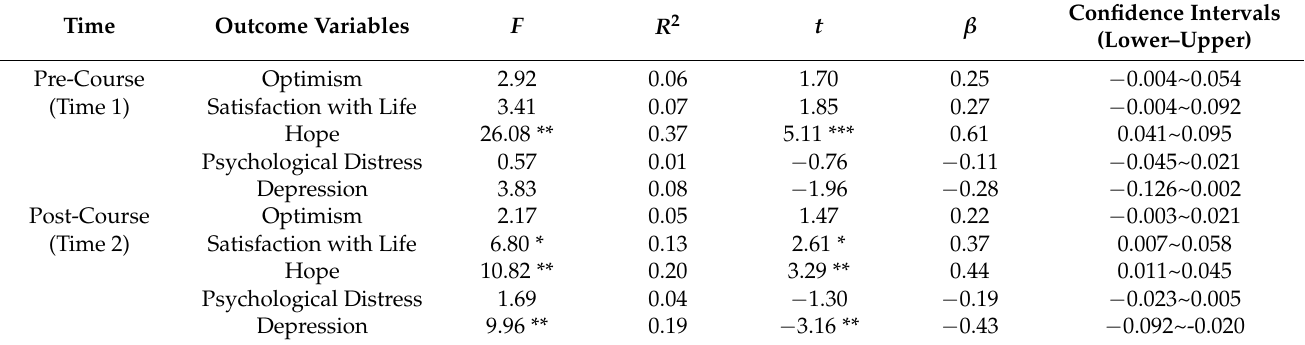
Table 7. Results of regression analyses with emotional intelligence as predictor variable (study